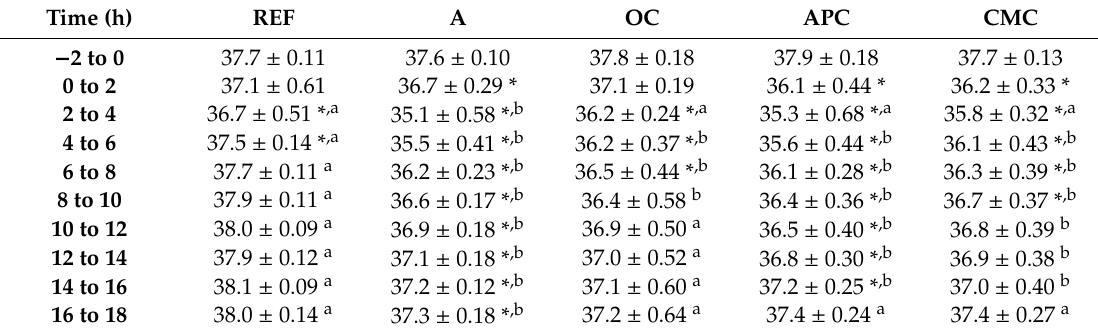
* represents statistical di ff erences vs. their own basal values before challenge ( − 2 to 0) ( p < 0.05). Values not sharing letters denote significant di ff erences between groups during the same period of time ( p < 0.01) while values sharing the same letter did not di ff